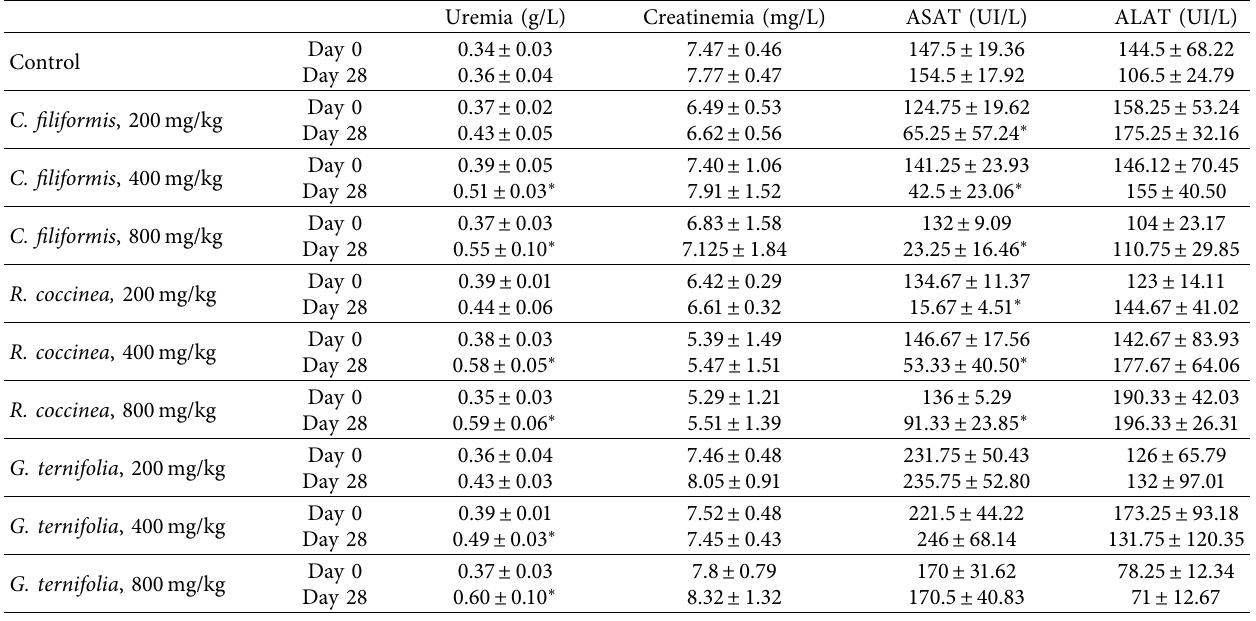
Table 2: Effect of studied plants extracts on biochemical parameters of rats in different lots.